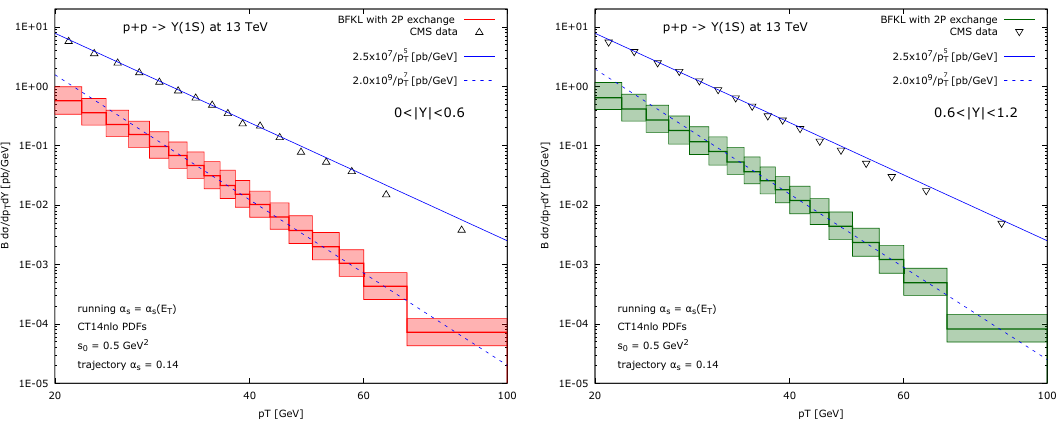
Figure 15 . Same as in figure 11 but for hadroproduction of Υ(1 S